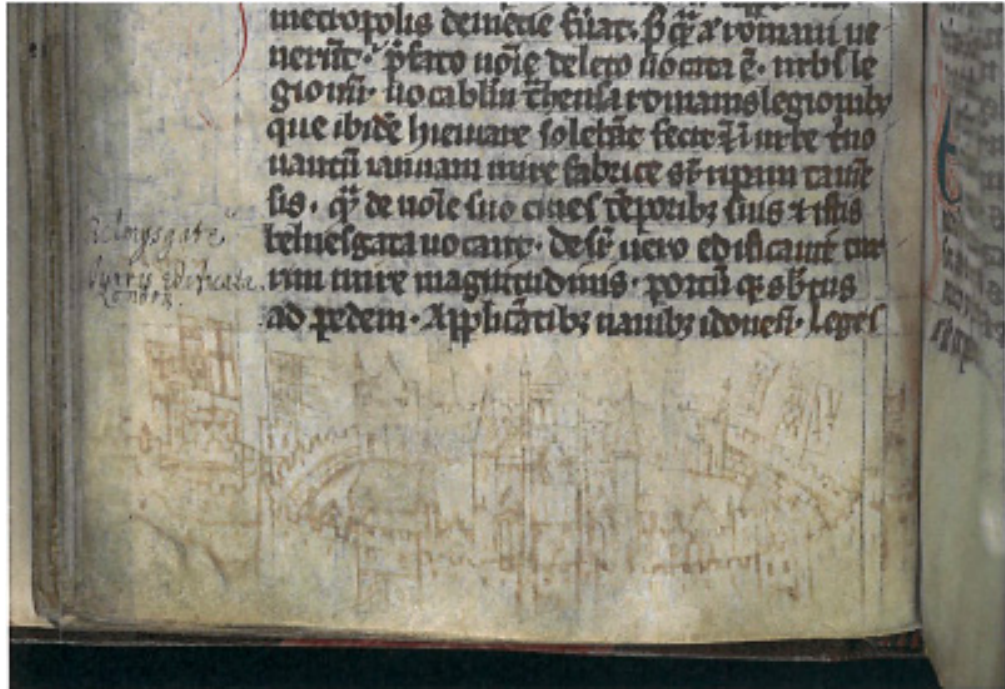
Fig. 2. Drawing of Caerleon (alternately described as London) in lead and ink, probably fourteenth century. London, British Library, Royal MS. 13 A. III, f.